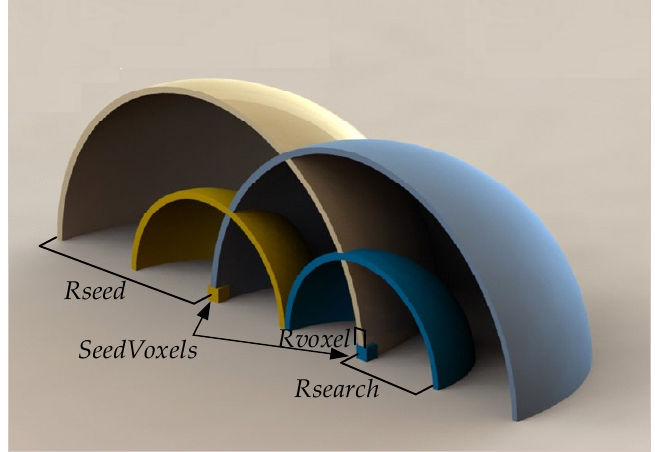
Figure 6. Parameters of seed selection.